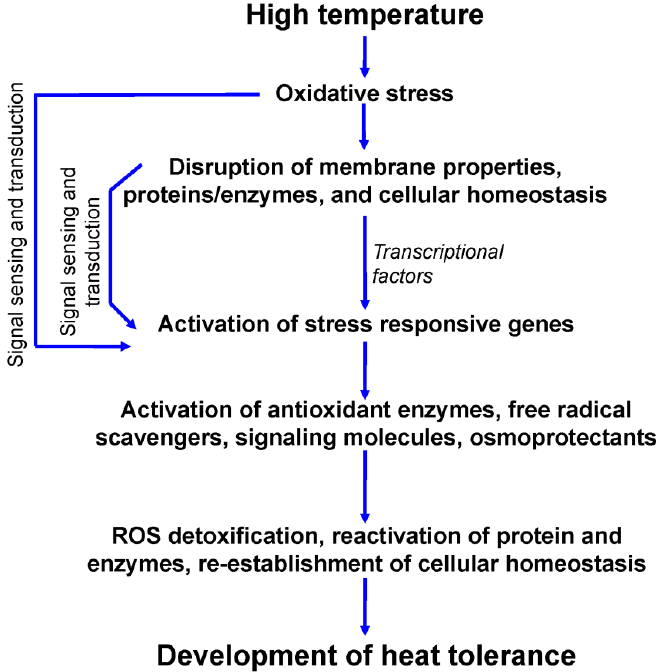
Figure 5. Schematic illustration of heat induced signal transduction mechanism and development of heat tolerance in